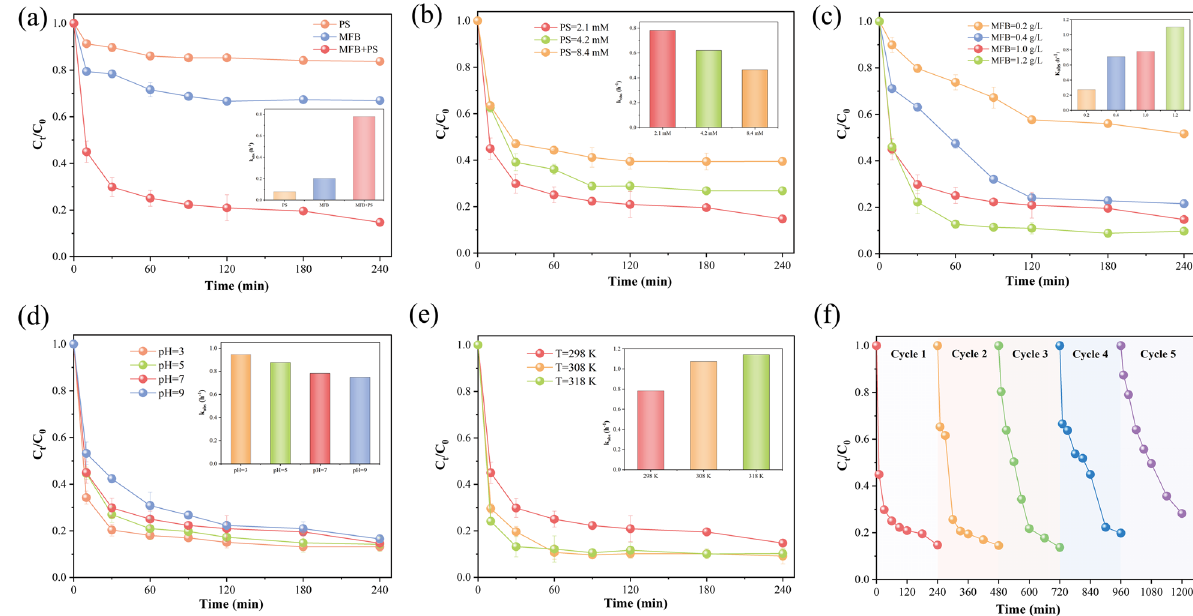
Fig. 3 p -ASA degradation efficiencies by BC, and MFB ( a ), p -ASA degradation by MFB under different pH ( b ), PS concentrations ( c ), MFB dosages ( d ), reaction temperatures ( e ), and reusability of MFB